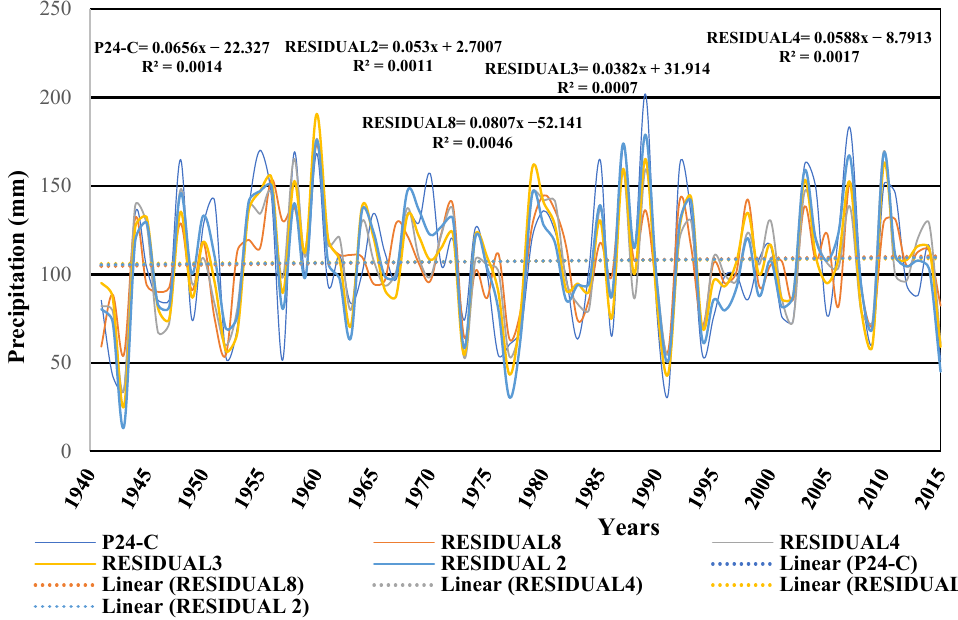
Figure 5. Maximum precipitation in 24 h and Residuals 2, 3, 4 and 8.